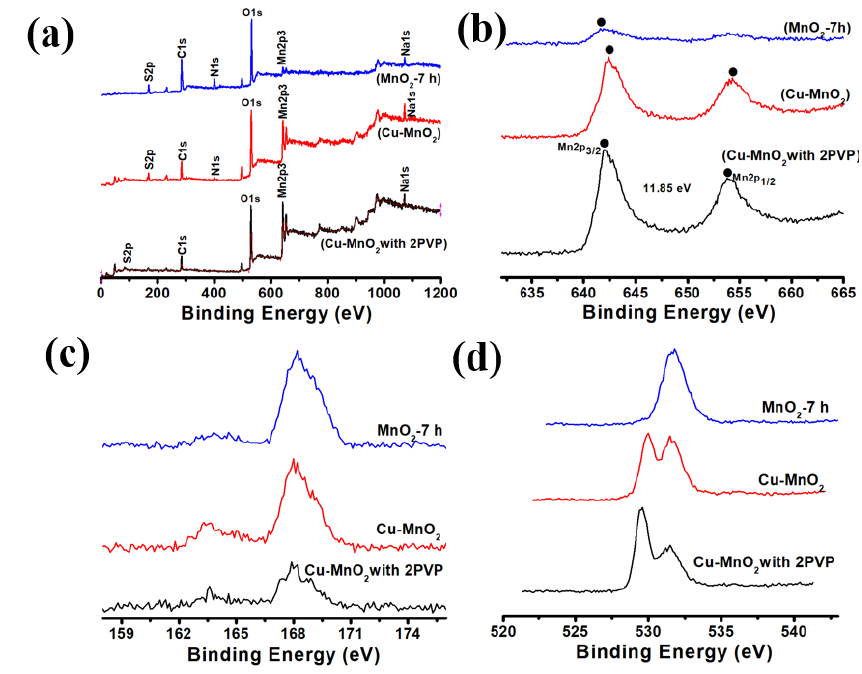
Figure 3. The XPS survey spectrum of (a) MnS-7 h, Cu-MnS, Cu-MnS with 2PVP and high resolution spectrums of (b) Mn2p, (c) S2p and (d) O1s of MnS-7 h, Cu-MnS and Cu-MnS with 2PVP composite.